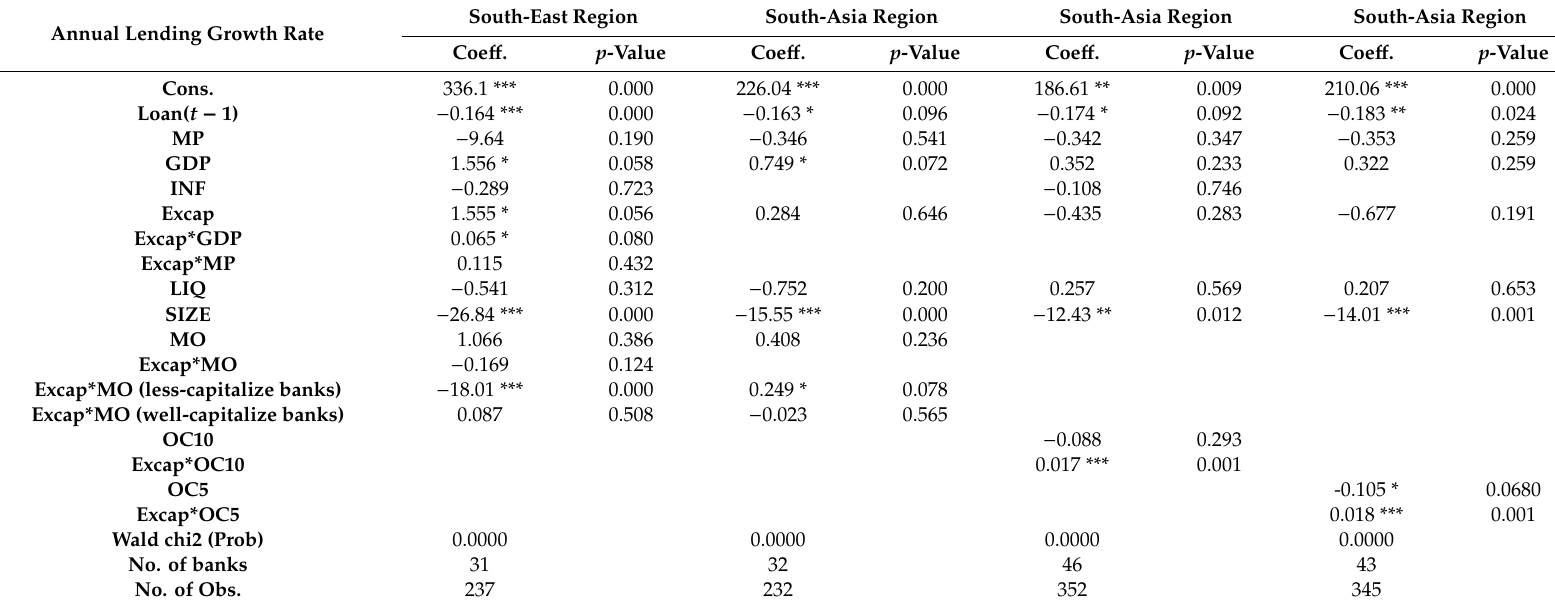
Table A2. Ownership Model Sub-Sample